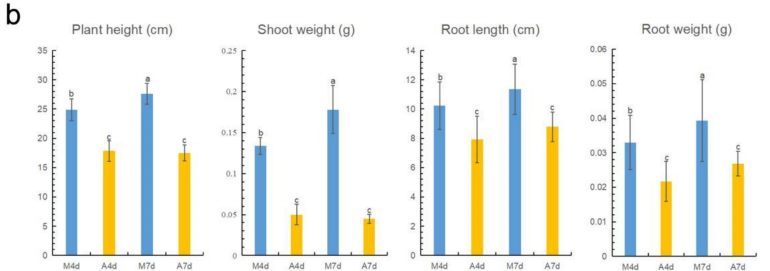
Figure 1. Plant phenotype variation under alkaline stress with high pH condition. Seedlings at the trefoil stage were subjected to an alkaline treatment (pH 11.5). ( a ) Time-course observation for tolerance phenotype on fourth day, and seventh day after the start of treatment in shoot and root of Dongdao-4. ( b ) Overall plant status including plant height, shoot weight, root length and root weight. M4d, A4d, M7d and A7d stand for fourth-Mock, fourth-stress, seventh-mock and seventh-stress, separately. The different letters above the columns represent significant differences ( p < 0.05) on the basis of Duncan’s new multiple range